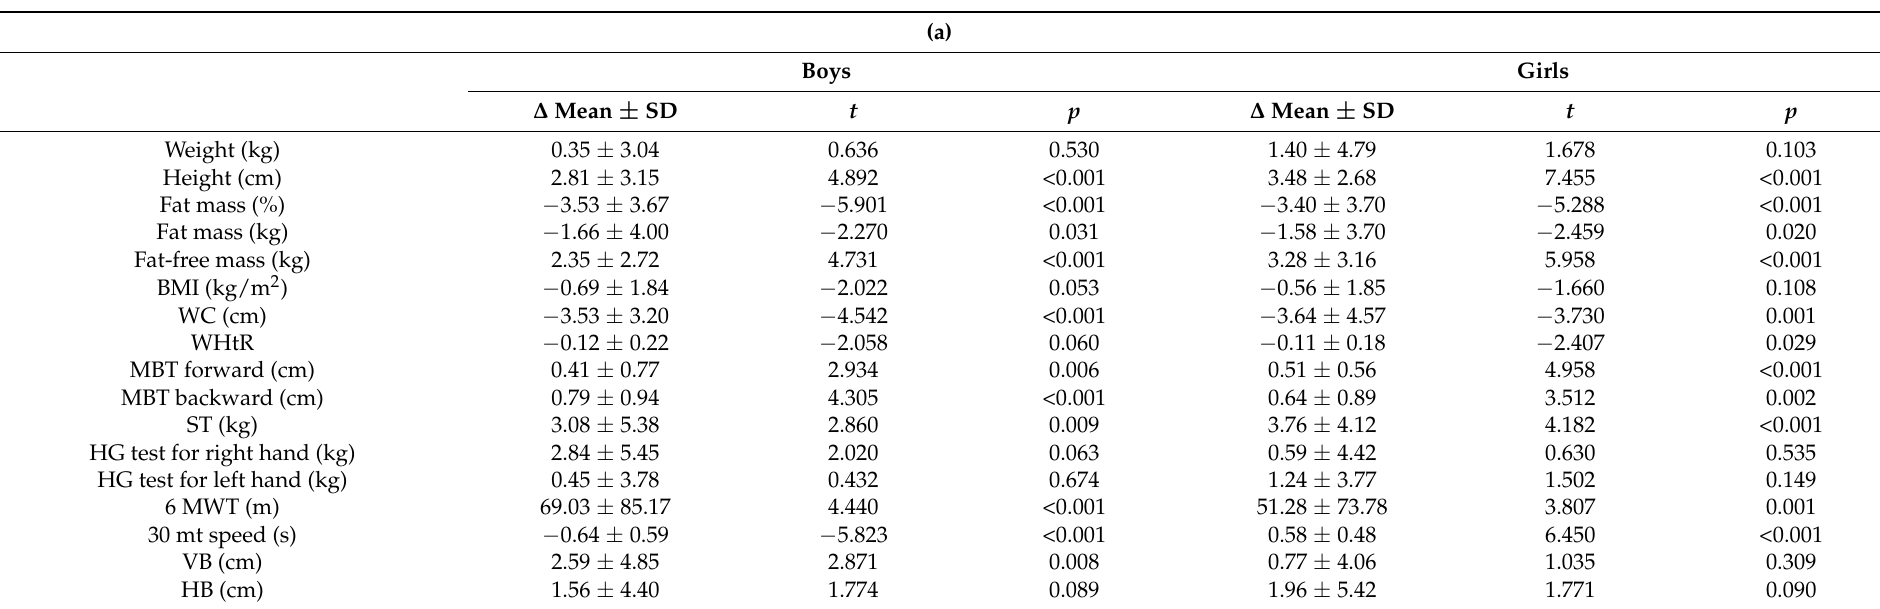
Table 3. ( a ) Post-intervention assessments: Anthropometric and Physical Performance measures values in the children subgroup. Results are presented as ∆ (T1 − T0), means, and SDs. Statistical significance was set for p values ≤ 0.05. ( b ) Post-intervention assessments: Anthropometric and Physical Performance measures values in the adolescents’ subgroup. Results are presented as ∆ (T1 − T0), means, and SDs. Statistical significance was set for p values ≤